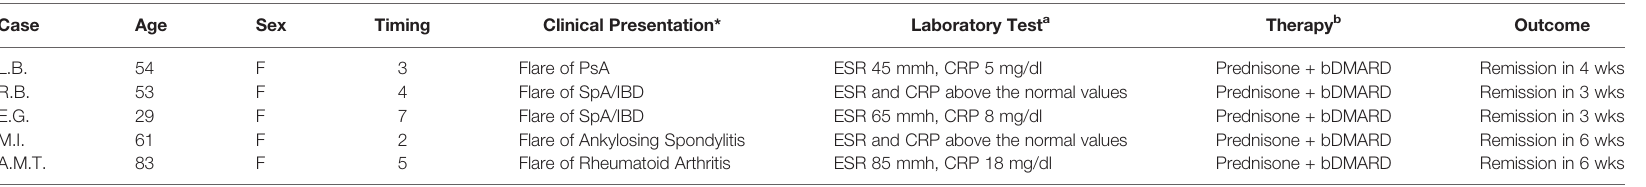
citrullinated protein antibodies (ACPAs), and anti-Ro, anti-La, anti-dsDNA, anti-Sm autoantibodies were tested. There are shown only the test resulted out of the normal value. b Prednisone was added to the biologic-disease-modifying anti-rheumatic drug (b-DMARD; adalimumab in cases 1-3, secukinumab in case 4) at the dose of 25 mg/day, scaling the dose until the stop in the weeks shown in the table. Wks, weeks; ESR, erythrocyte sedimentation rate; CRP, C-reactive protein; MMF, Mycophenolate mofetil; PsA, psoriatic arthritis; SpA/IBD, spondyloarthritis associated with in fl ammatory bowel disease (Crohn